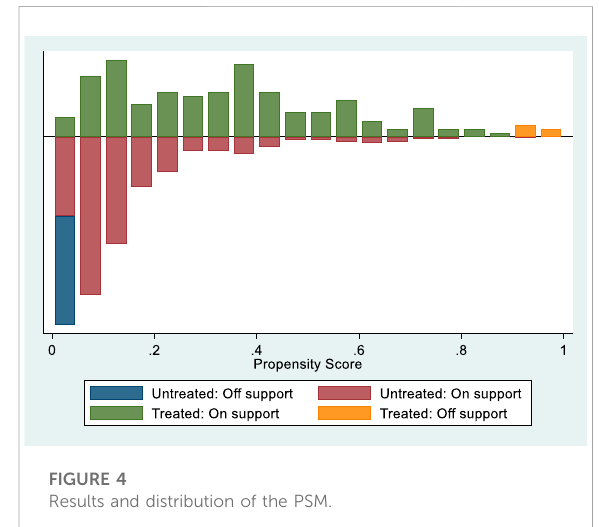
FIGURE 4 Results and distribution of the PSM.